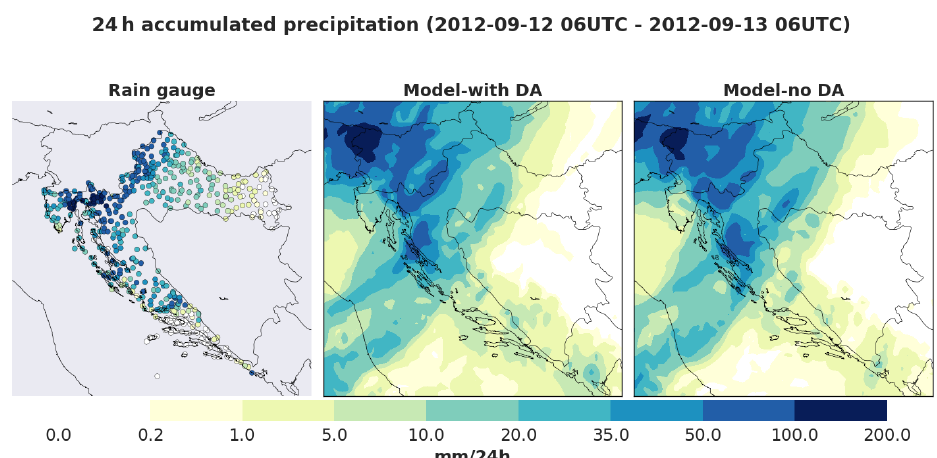
Figure 17. The 24h accumulated precipitation from 12 September 06:00UTC until 13 September 06:00UTC (IOP12). Left: rain gauge measurement. Middle: ALADIN 8km operational forecast with data assimilation. Right: ALADIN 8km forecast without data